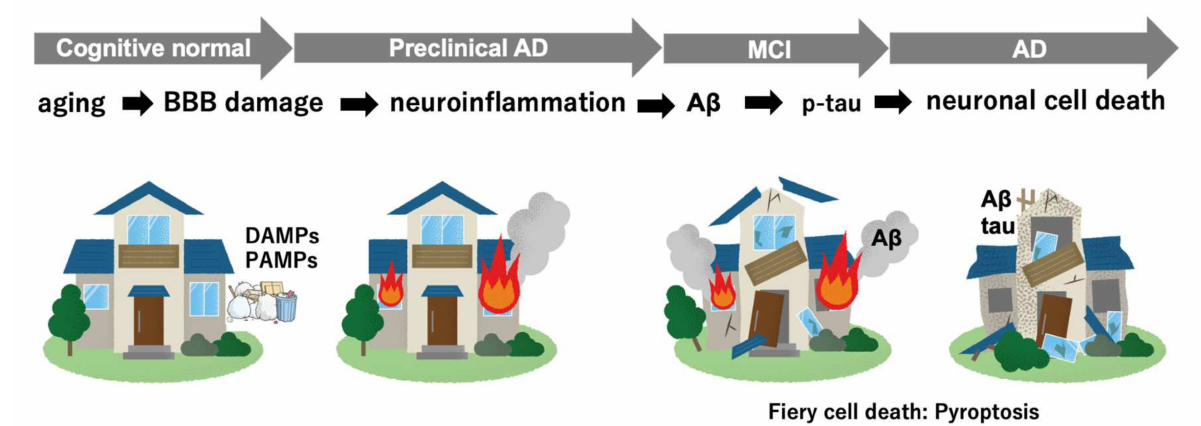
Figure 3. Illustration of disease progression from preclinical stages to onset of Alzheimer’s